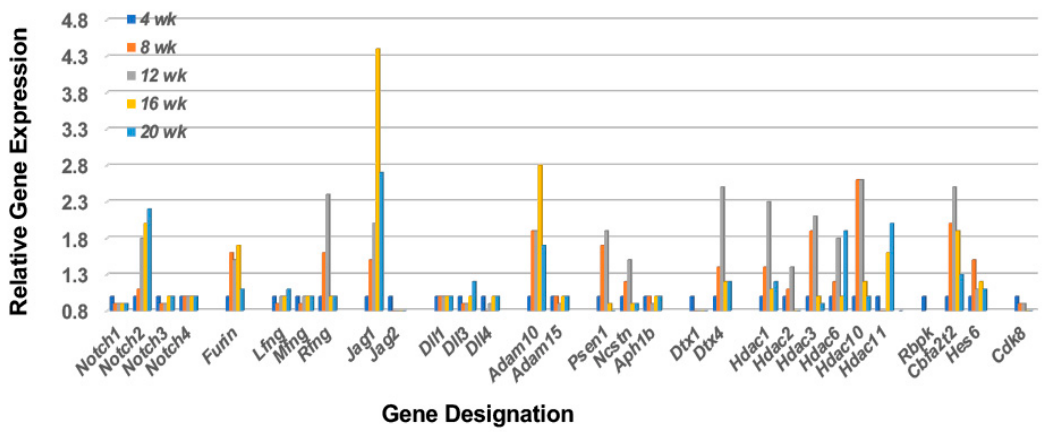
Figure 1. Prolonged upregulated activation of the Notch2 signal transduction pathway in lacrimal glands prior to and during onset of the adaptive response. Notch2 is a transmembrane protein receptor whose extracellular portion is post-translationally modified in the Golgi bodies by furin and fringe molecules (i.e., Lfng, Mfng, or Rfng) prior to its insertion into the cellular membrane, thus enhancing subsequent MZB cell functions. On activation by a Notch2 ligand (i.e., Jagged and/or Delta molecules), the Notch2 molecule undergoes sequential cleavage first by Adam10 and then by γ -secretase, thereby releasing the cytoplasmic protein Dtx (an E3 ubiquitin ligase), as well as the Notch intracellular domain (NICD) that gets transported into the nucleus. In the nucleus, NICD displaces corepressors, including HDACs (histone deacetylase complex), allowing direct interaction with Rbpk to activate Hes, thus driving Notch2-regulated gene transcription. Downregulation of the Notch2 pathway occurs through phosphorylation of NCID by Cdk8 that initiates polyubiquitination and proteasome degradation. In this model, however, while the Notch2 pathway remains activated, Cdk8 exhibits, at best, minimal upregulated expression, suggesting the MZB cells may persist and over time differentiate from their effector function to their APC function for invoking the adaptive response.